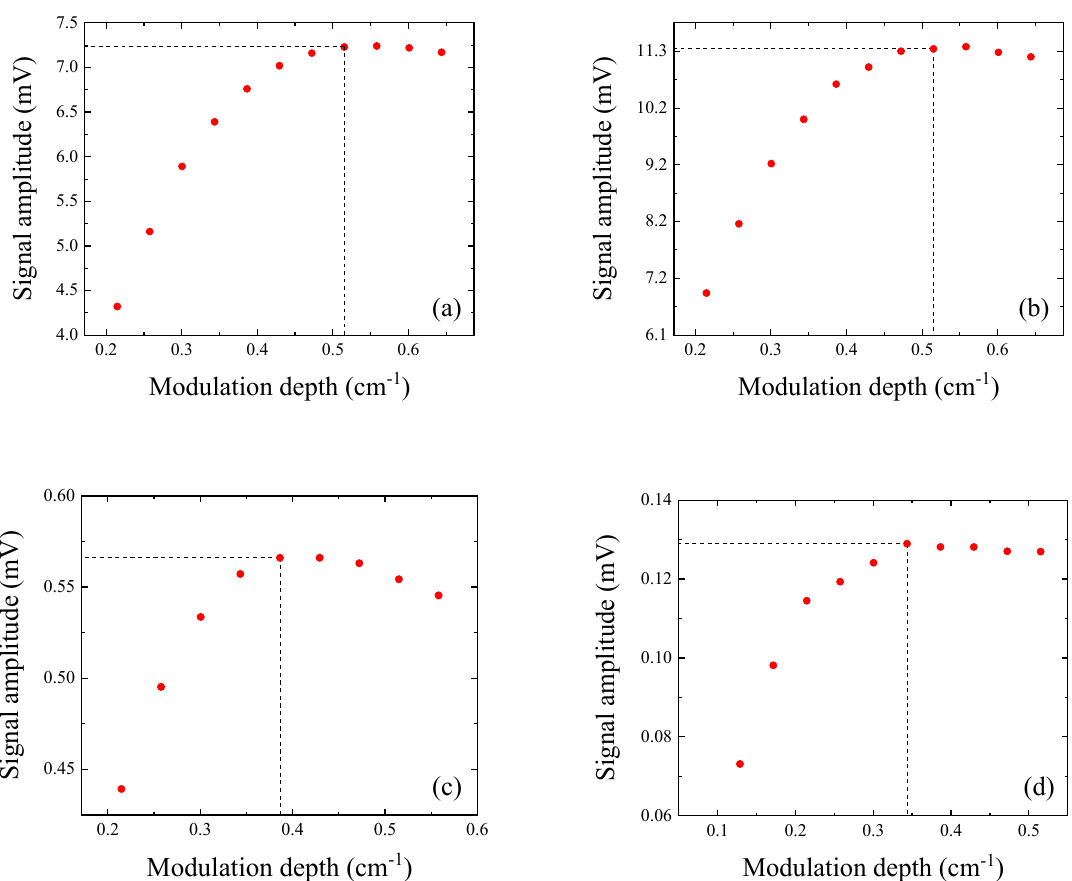
Figure 5. 2 f QEPAS signal amplitude as a function of modulation depth for QTF#1 ( a ), QTF#2 ( b ), QTF#3 ( c ), and QTF#4 ( d ).